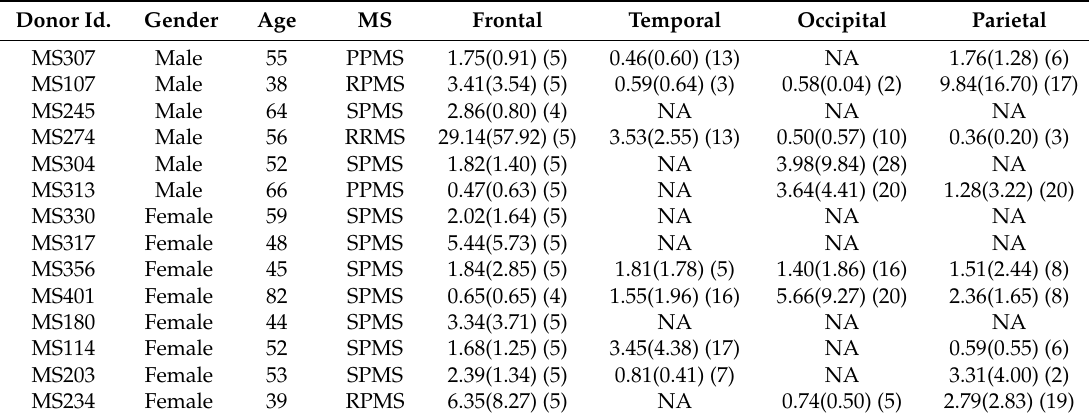
Table 1. Brain aluminium content ( µ g/g dry wt. mean (SD) (n)) for each lobe of each